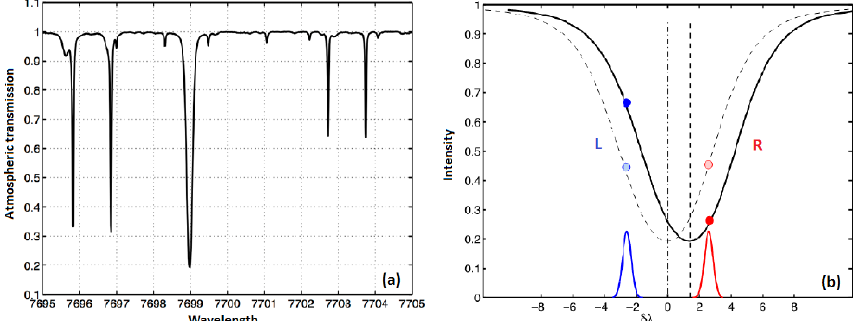
Figure 2. (a) Atmospheric transmission within the Mark-I interference filter bandwidth, and (b) the relative displacement of the solar line (solid black curve) with respect to the laboratory line (dashed curve) measured as a function of R and L .